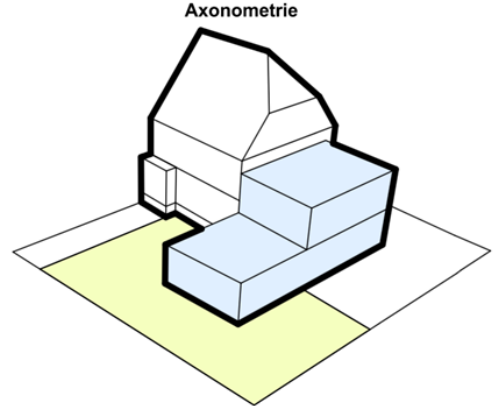
Figure 5. 3D Visualization of possible densification process (source: project